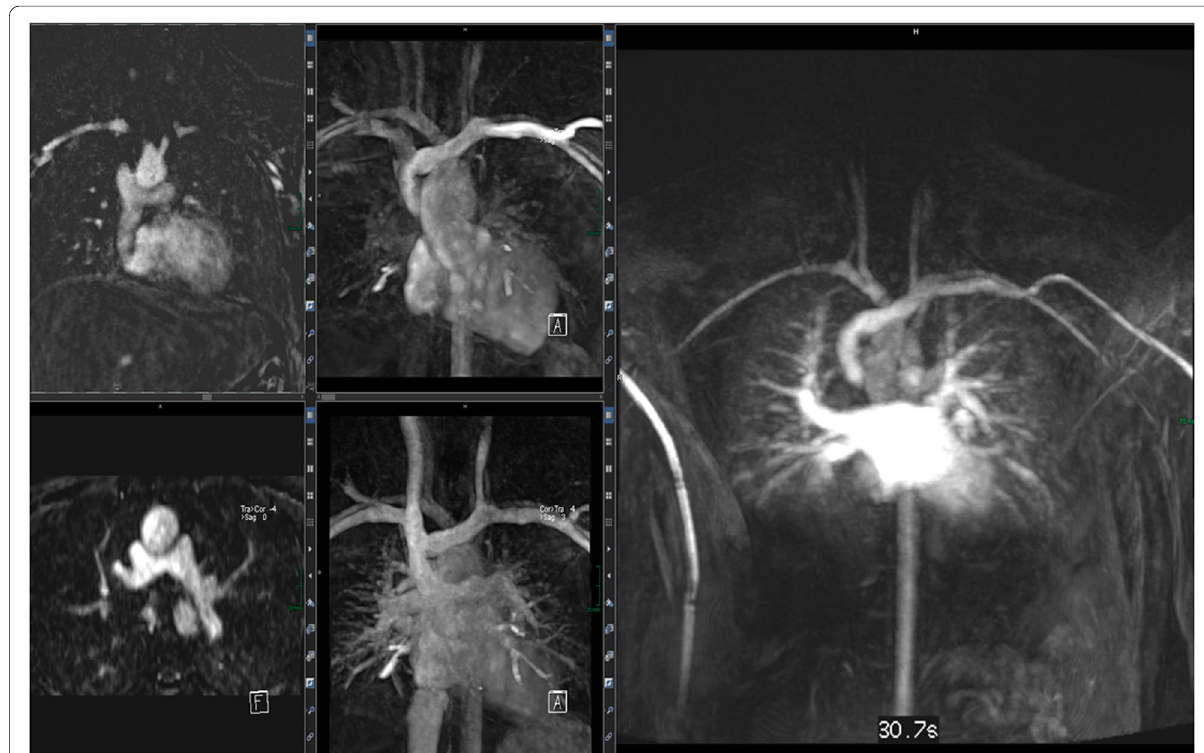
Fig. 12 (MRA): connection between VCS, VCI, and right pulmonary artery. The 4 smaller images show the connections (upper and lower images on the left as single images in high resolution; upper and lower images in the middle as thicker MIPs for an overview). The right larger image is one data set of the MR angiography, which gives an idea about pulmonary blood